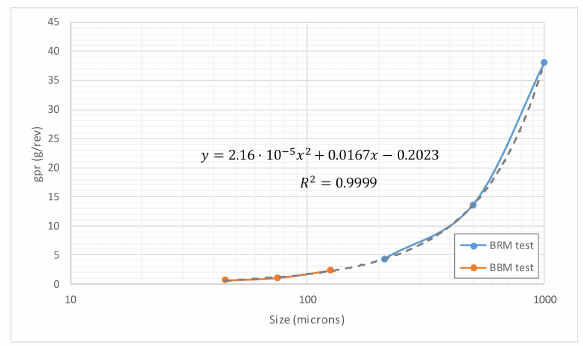
Figure 5. Variation of BBM and BRM gpr values with P 100 , Penouta mine ore.